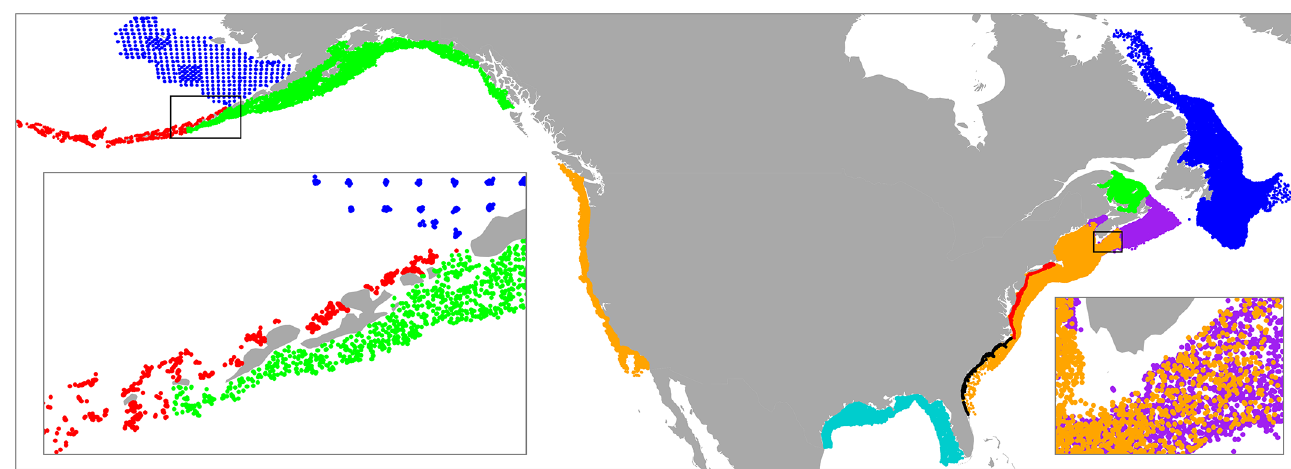
Fig 1. Biological survey regions. Locations for 136,044 bottom trawl hauls from long-term ecological surveys conducted on the North American continental shelf. Hauls are colored to indicate the different survey regions described in Table 1.